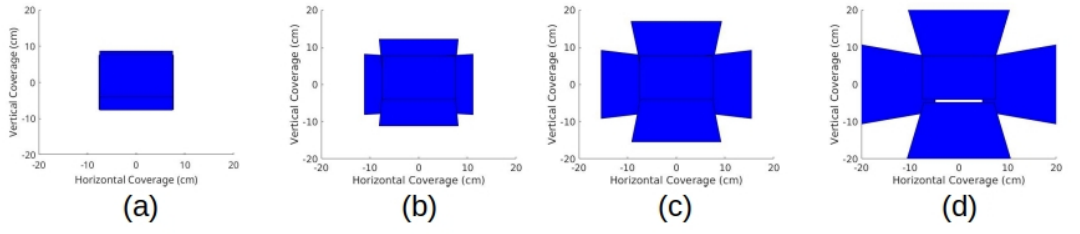
Figure 3. FoV Selection: A comparison of the FoV for cameras placed at a ( a ) 0 ◦ , ( b ) 10 ◦ , ( c ) 20 ◦ , and ( d ) 30 ◦ angle. When the angle is too small, the FoV is not maximized. On the contrary, when the angle is too large, holes begin to form in the